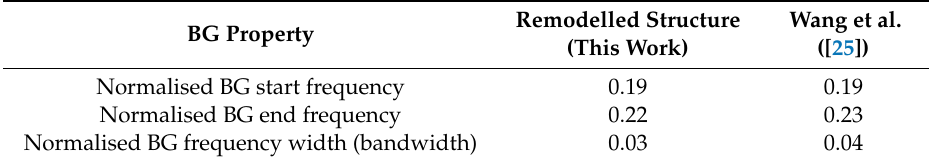
Table 5. BG properties as identified in this work and reported by Wang et al. [25].